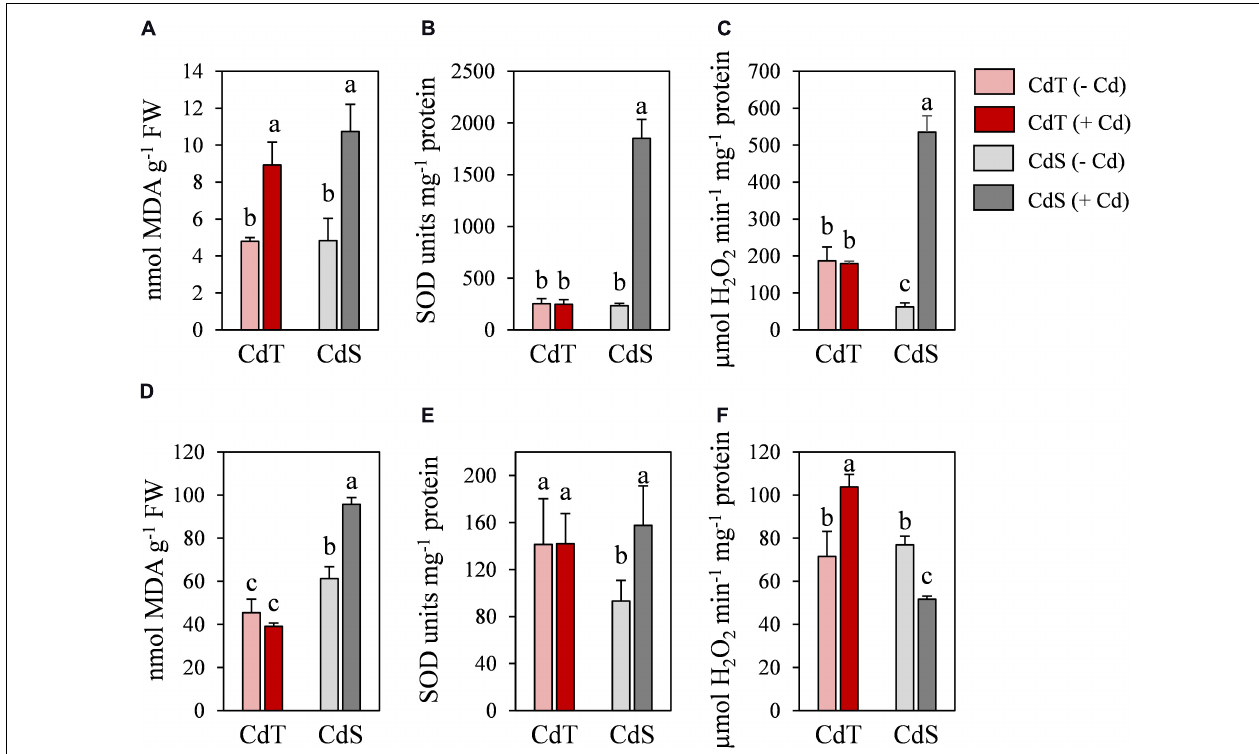
FIGURE 10 | Lipid peroxidation (MDA), and SOD and catalase activities in M. truncatula cultivars CdT (tolerant) and CdS (sensitive) grown in pots containing vermiculite with 0 or 100 µ M CdCl 2 for 15 days. (A–C) Roots. (D–F) Shoots. Different letters indicate significant differences (Tukey HSD test, p ≤ 0.05, n =